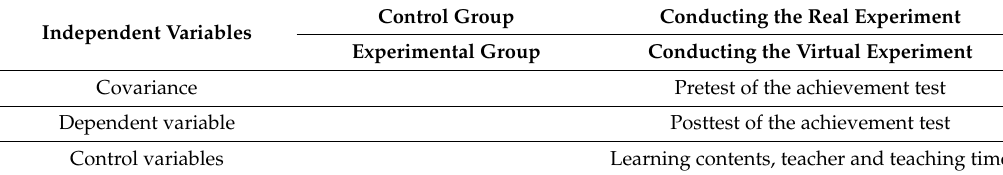
Figure 16. Flowchart of the teaching experiment. Table 1. Variables of the teaching experiment.